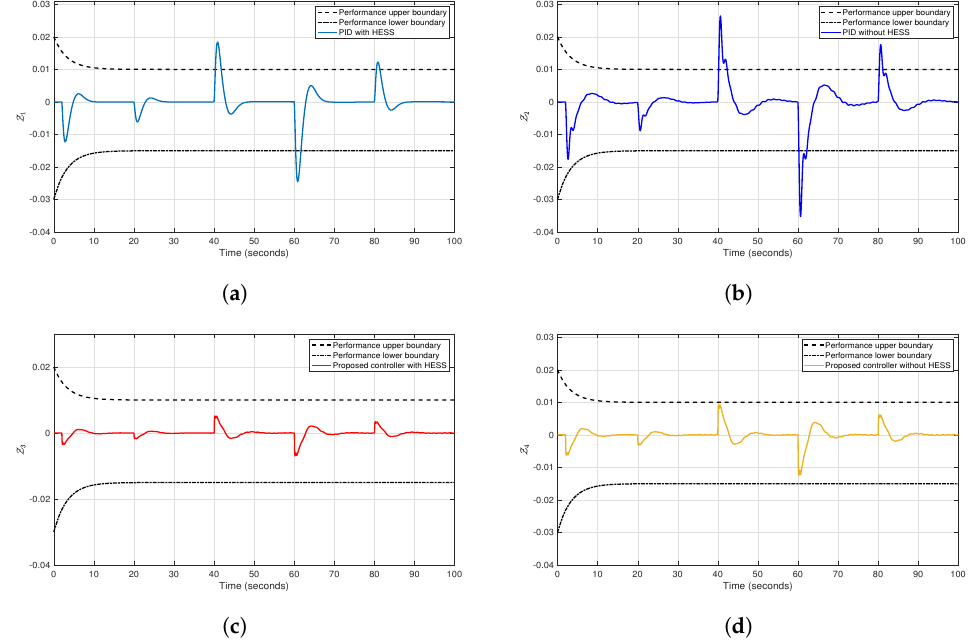
Figure 6. The time response of the tracking error Z 1 ( t ) : ( a ) response under PID controller with HESS; ( b ) response under PID controller without HESS; ( c ) response under proposed controller with HESS; ( d ) response under proposed controller without HESS.